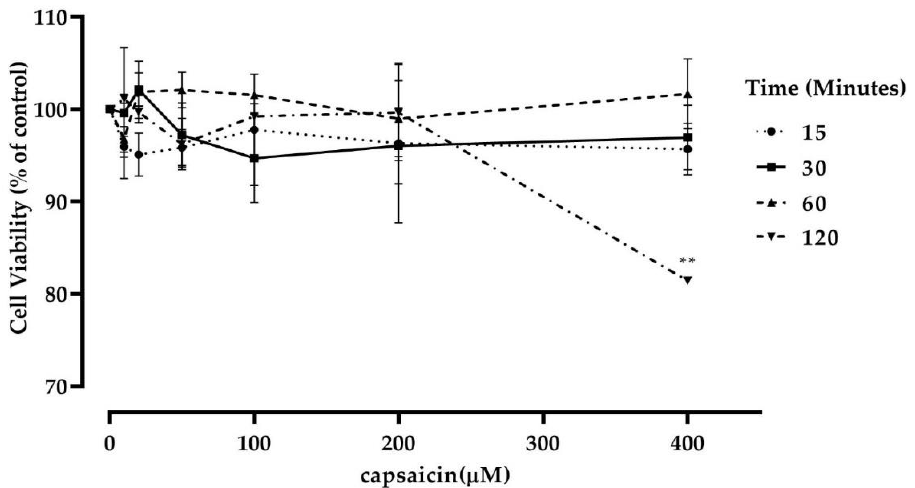
Figure 3. Effect of capsaicin treatment on C2C12 skeletal muscle cell viability. Data are presented as the mean ± SD of three independent experiments ( n = 3). ** p < 0.01 indicates a significant difference between capsaicin-treated and control groups.